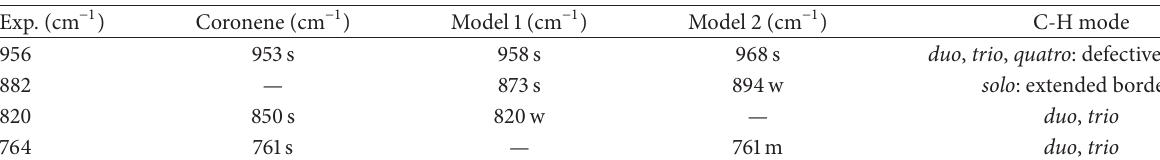
Table 1: Frequencies values (in cm −1 ) of the main bands observed in the experimental INS spectrum of CW in the C-H out-of-plane bending region (ii) and values calculated for the two models shown in Figures 2(a) and 2(b), with relative intensities (s = strong, m = medium, and w = weak). The assignment to the specific C-H out-of-plane mode is indicated in the last column.